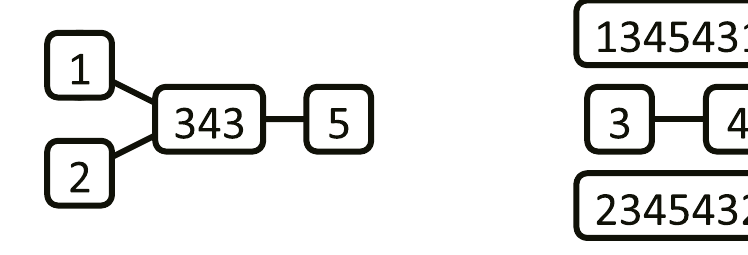
Figure 4 . The Dynkin diagram of the D 4 subalgebra within the original D 5 algebra which preserves the (2 ; 2) model without rank deformations (Left) and that of the ( A 1 ) 2 (cid:2) A 2 subalgebra which preserves the (1 ; 1 ; 1 ; 1) model without rank deformations